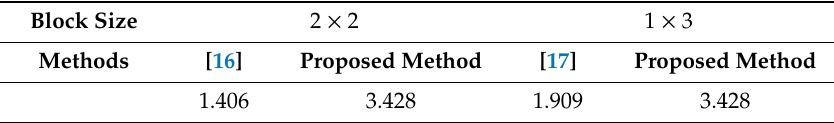
Table 8. Estimated embedding e ffi ciencies of Imaizumi et al.’s [16], Aryal et al.’s [17], and the proposed methods with k =